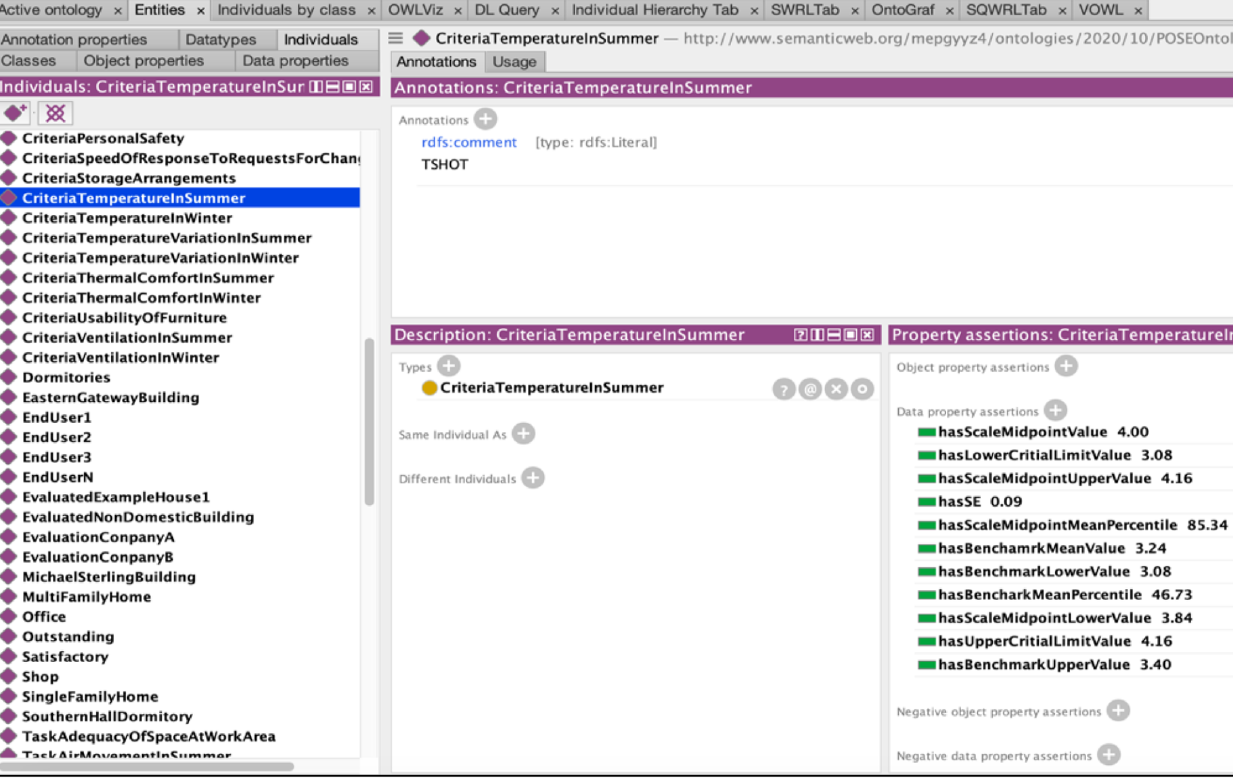
Fig. 5. The individuals of proposed